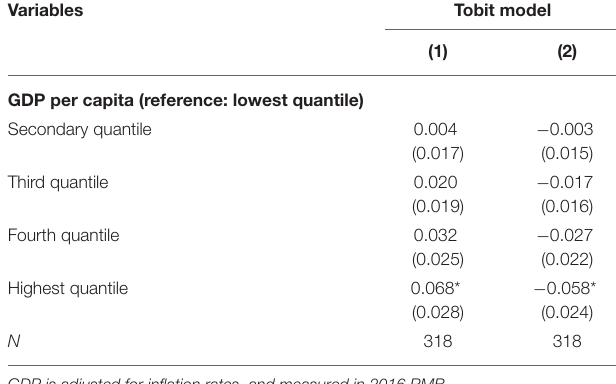
TABLE 5 | Results of tobit model regression on inefficiency scores and OLS regression on efficiency scores.